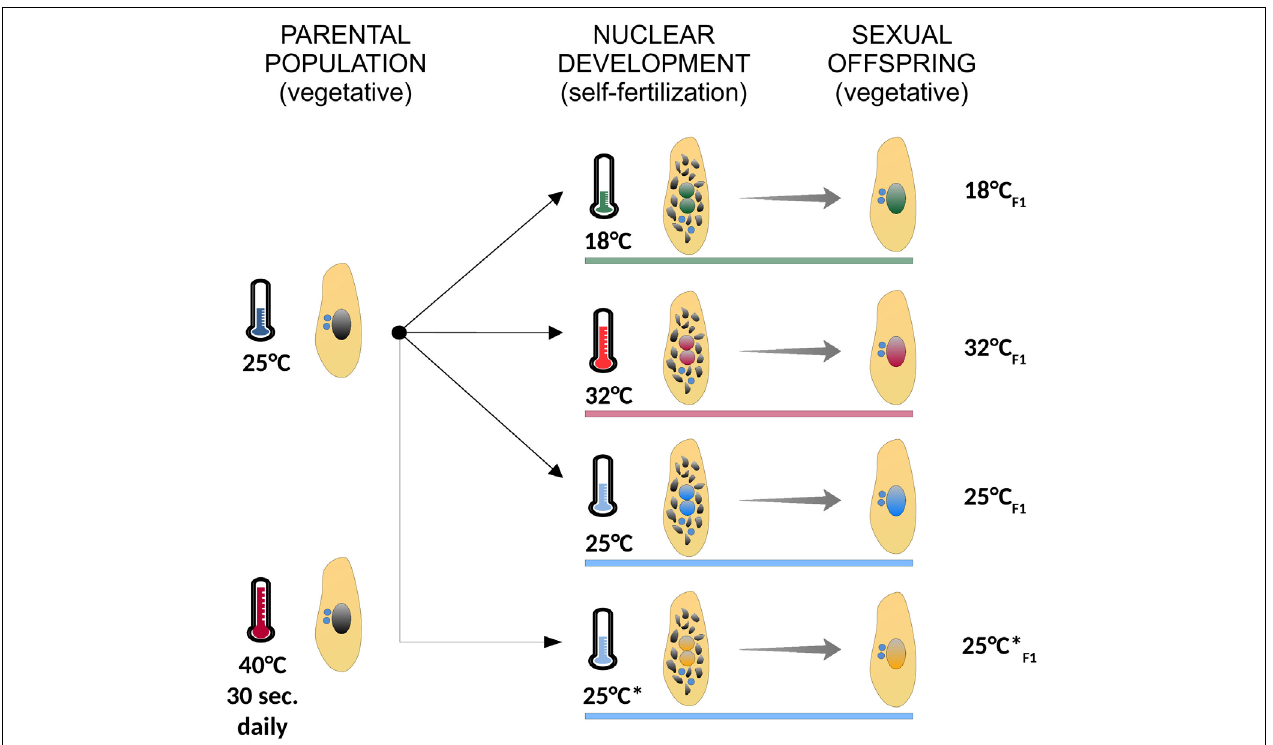
FIGURE 2 | Summary of the experimental treatments used in the study. A fully clonal population of paramecia (identical germ line and somatic genomes) was cultured at 25 ◦ C, and subjected to different environmental temperatures during self-fertilization (18 ◦ C, green; 32 ◦ C, red; 25 ◦ C, blue; 25 ◦ C*, orange), when somatic genome development takes place. In the following vegetative phase, when cells divide asexually, the ensuing sexual offspring was expanded to mass culture for genomic DNA sequencing. The parental population from which Line 25 ◦ C* F 1 originates was subjected to a daily 40 ◦ C-heat shock for 30 s. Cells were grown at the indicated experimental temperature (colored horizontal bars) both during nuclear development (self-fertilization) and the ensuing vegetative phase (sexual offspring). Asexually dividing cells are depicted with a large intact somatic nucleus (black in the parental population and colored by treatment in the sexual offspring). Self-fertilizing cells are depicted during nuclear development with two developing nuclei (with colors matching the treatment) and the old somatic nucleus on its way to be fully degraded (multiple black fragments). Germ line nuclei are depicted in blue.